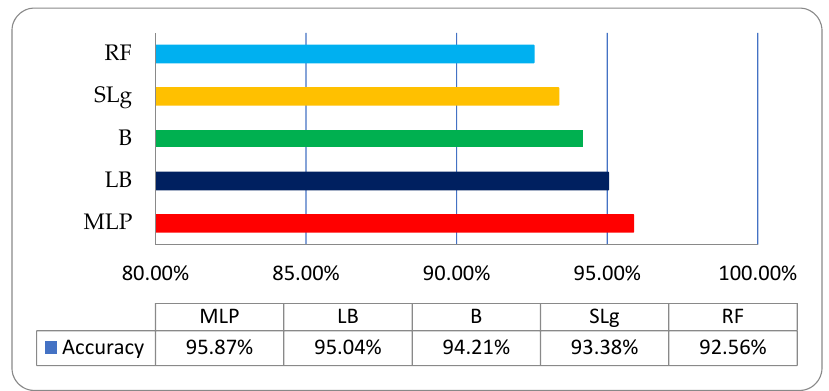
Figure 8. Medicinal plant leaves classification graphic on ROI’s (220 × 200).